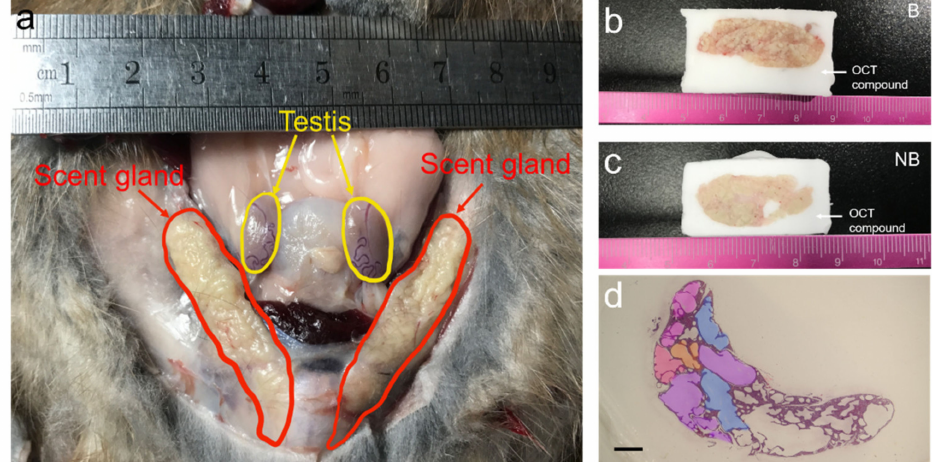
Figure 1. Anatomic localization and whole-tissue sections of the scent glands in muskrats during the breeding and non-breeding seasons. ( a ) The anatomic localization and morphology of the scent glands; ( b , c ) the scent glands held into position using OCT compound during breeding and non- breeding seasons; ( d ) the cross-section of scent glands. The purple section represents large duct, blue section represents medium duct, orange section represents small duct, pink section represents fine duct. B, the breeding season; NB, the non-breeding season. Scale bars = 125 µ